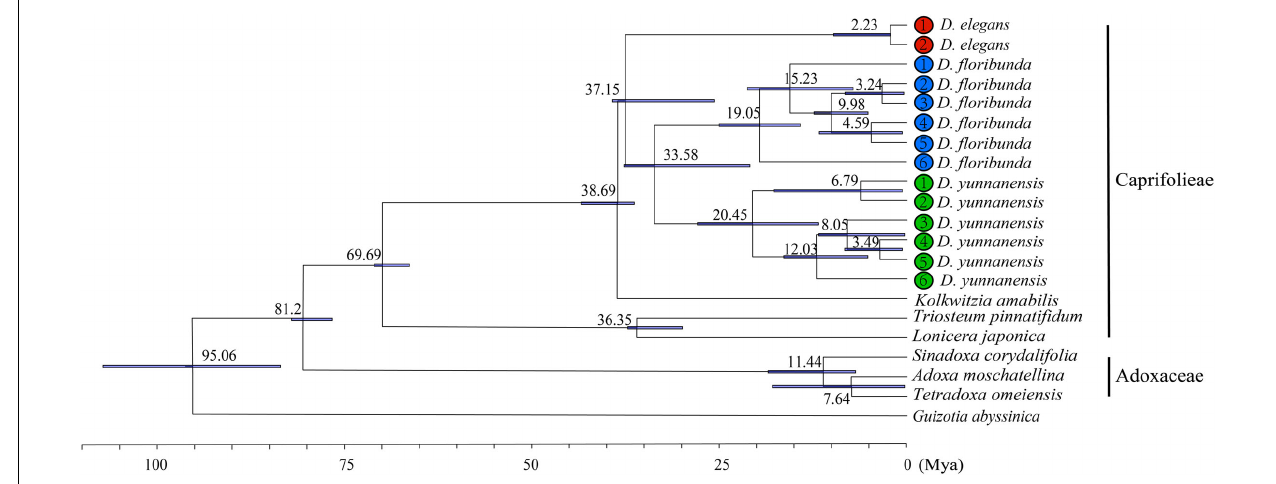
FIGURE 8 | Molecular dating of nine Dipsacales species based on the complete plastomes.